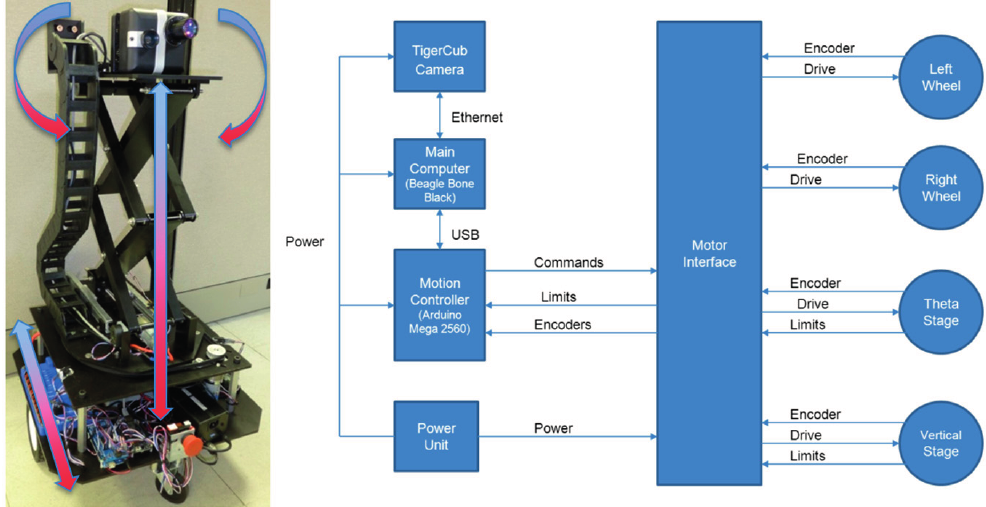
Figure 11. Ground navigation robot ( left ) and its system block diagram ( right